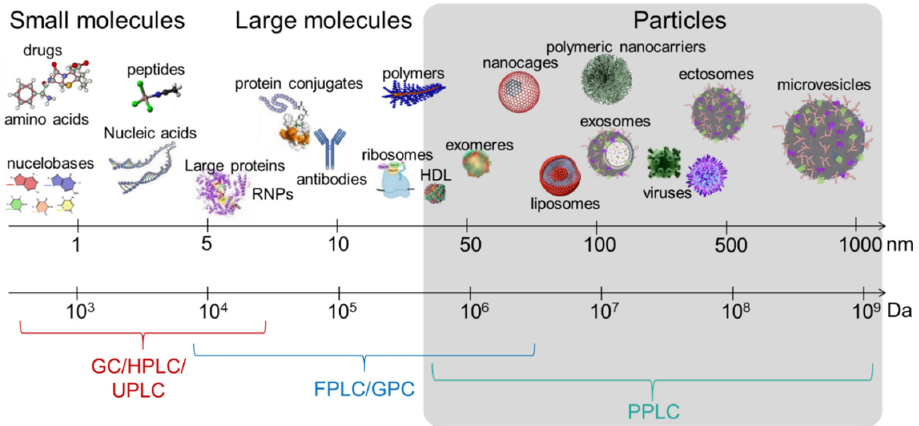
Figure 2. Schematic depicting the limits of the commercially available chromatographic systems in EV separation. GC, gas chromatography; HPLC, high performance liquid chromatography; UPLC, ultra-high performance liquid chromatography; FPLC, fast purification liquid chromatography; GPC, gel permeation chromatography. PPLC, particle purification liquid chromatography, which is currently under development (Kaddour et al.,), is tailored for mega- to gigadalton materials. Table 3. Summary of EV separation challenges and possible solutions using a PPLC system.